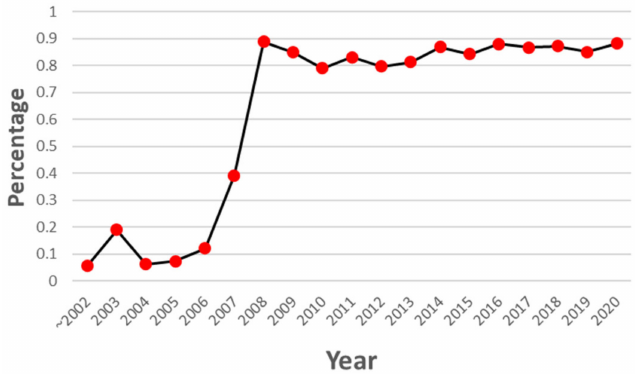
Figure 7. Changes in the percentage of CVE-ID that is linked to CWE-ID.